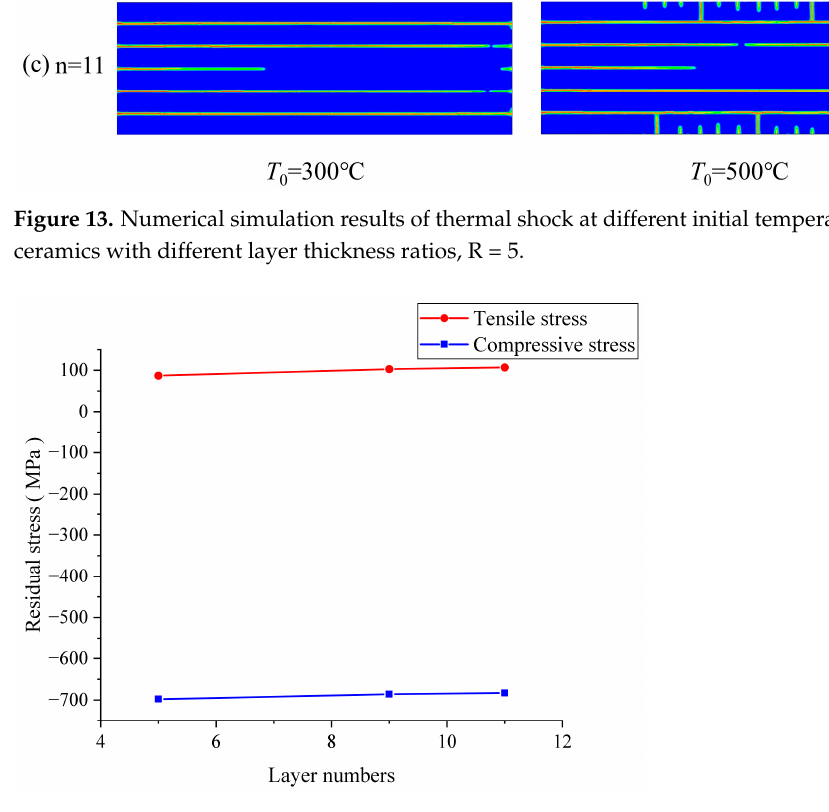
Figure 14. Residual stress of layered ceramics with different layer numbers.